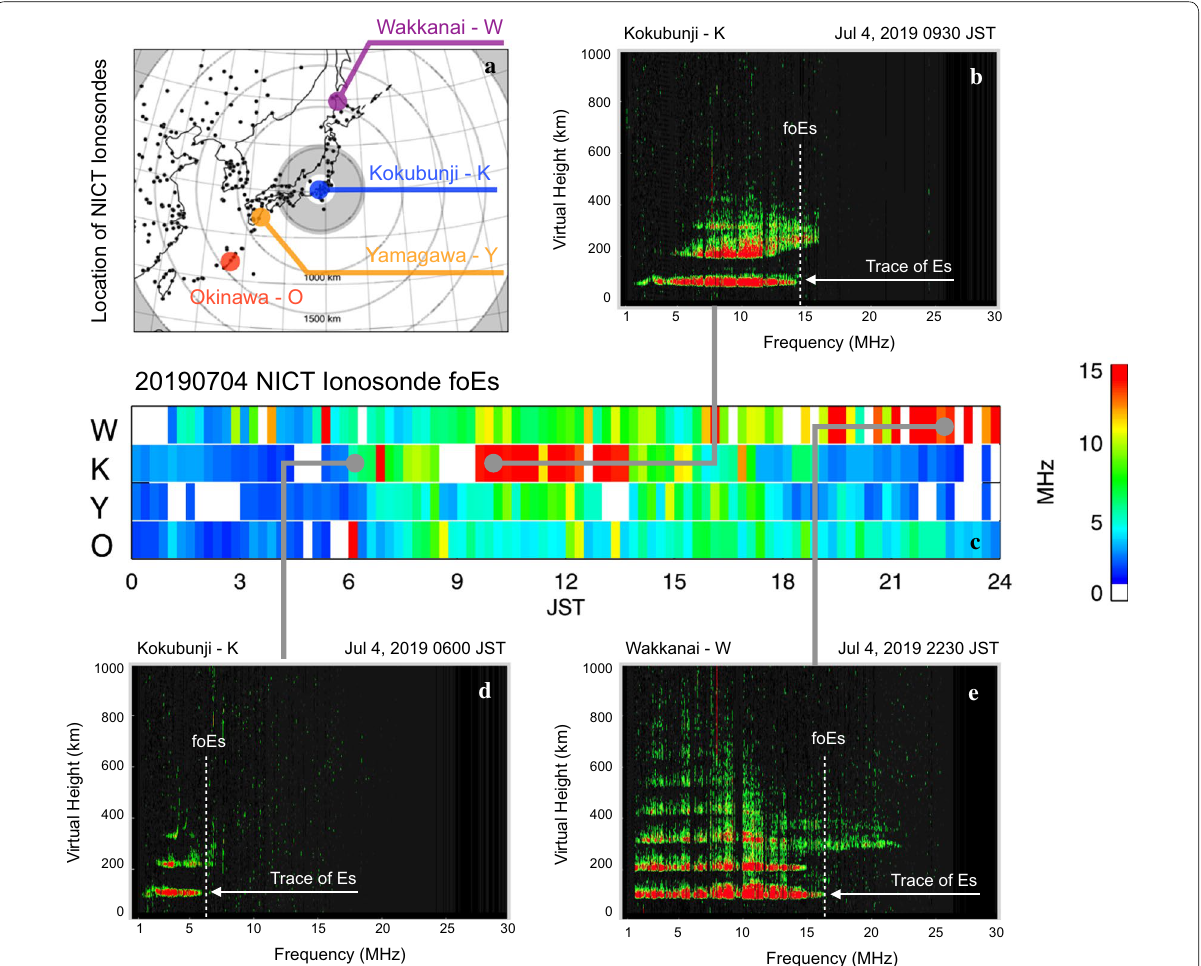
Fig. 5 Summary of ionosonde observations on July 4, 2019, a location of 4 ionosonde stations of NICT (Okinawa, Yamagawa, Kokubunji and Wakkakai), b ionogram from Kokubunji at 0930 JST, c variation of foEs values from 4 stations, d ionogram from Kokubunji at 0600 JST, e ionogram from Wakkanai at 2230